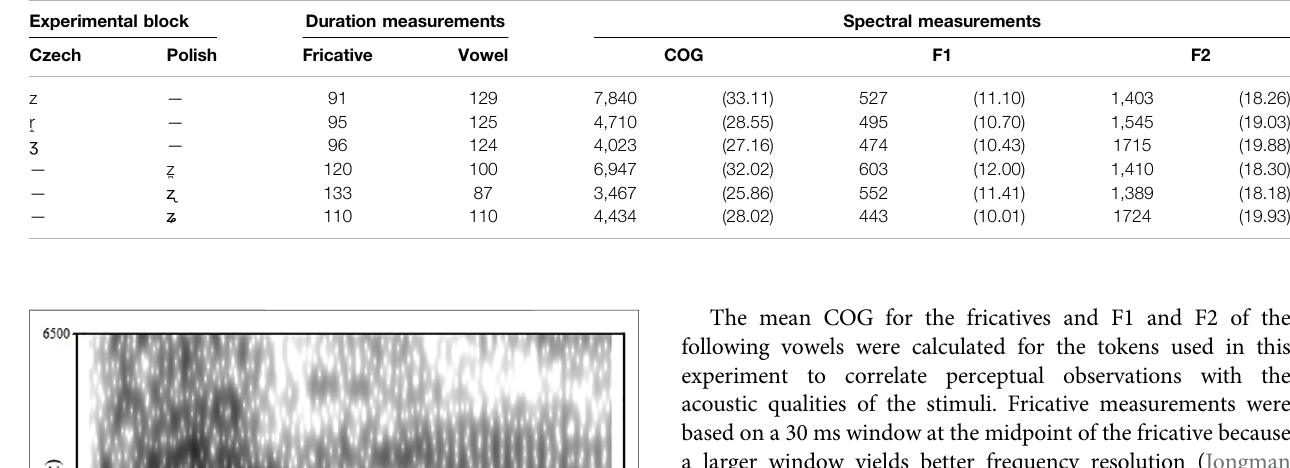
TABLE 2 | Mean spectral and duration measurements for the Czech and Polish sibilants in their respective experimental blocks. Duration measurements are provided in milliseconds. Spectral measurements are provided in Hz (ERB in brackets).